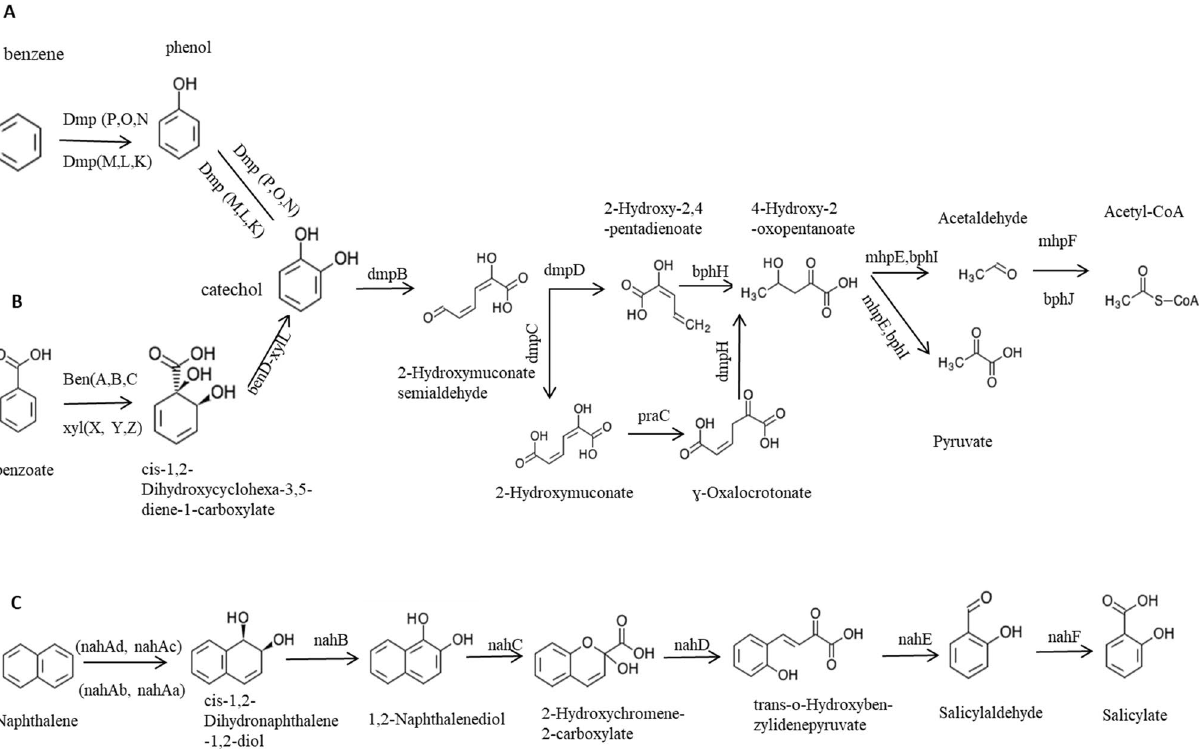
Figure 4. Benzoate ( A ), benzene ( B ) and naphthalene ( C ) pathways degradation in